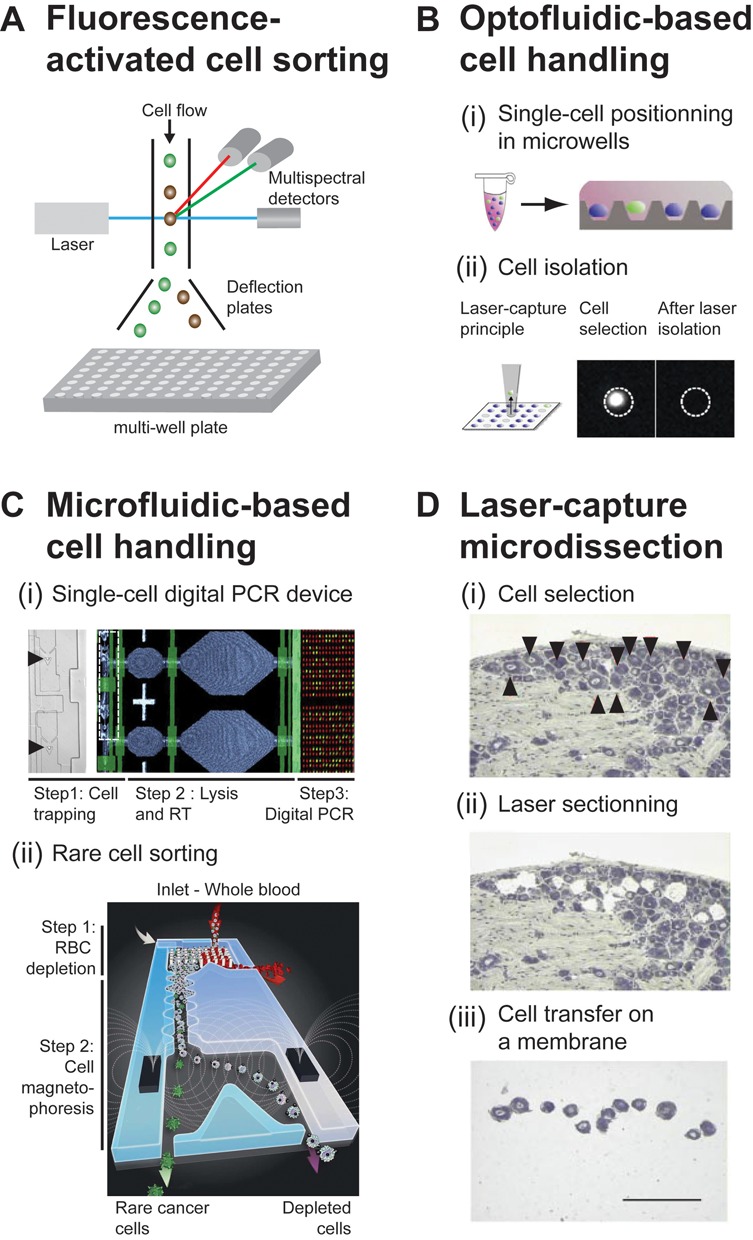
Methods to isolate single cells. (A) Principle of fluorescence-activated cell sorting. A stream of droplets, each containing a single cell, passes through an excitation laser beam and the fluorescence signal emerging from each cell is analyzed by a multispectral detector. If the emitted fluorescence signal gates in the preset window, the respective cell will be sorted into a multi-well plate. (B) Optofluidic-based cell handling. (i) A cell suspension is arrayed in a plate, each well containing a single cell. (ii) A laser, also called an optical tweezer, is used to manipulate each individual cell. Adapted from (62). Reprinted by permission from Macmillan Publishers Ltd on behalf of Scientific Reports, copyright 2013. (C) Two examples of emerging microfluidics-based cell sorting technologies. (i) A microfluidic system integrates all steps from single-cell trapping to gene expression analysis: (step 1) cells are retained individually in microfabricated chambers (each cell is indicated with a black arrowhead); (step 2) cells are lysed and RNA is reverse transcribed; (step 3) detection and analysis is achieved by digital PCR. Adapted with permission from (85,86). Copyright 2013 American Chemical Society. (ii) Representation of a microfluidic system that integrates all steps necessary for sorting extremely rare cancer cells from whole blood: (step 1) red blood cells (RBCs) are separated from white blood cells based on their size and (step 2) rare cells are further isolated from the stream of white blood cells by magnetophoresis. Adapted from (75). Reprinted by permission from Macmillan Publishers Ltd on behalf of Nature Protocols, copyright 2014. (D) Laser capture microdissection. (i) Cells of interest are identified in a stained section of rat cervical dorsal root ganglia (indicated by black arrowheads), (ii) cut with a UV laser and (iii) transferred onto a membrane. Scale bar 200 μm. Adapted from (82). Reprinted by permission from Macmillan Publishers Ltd on behalf of Nature Medicine, copyright 1999.